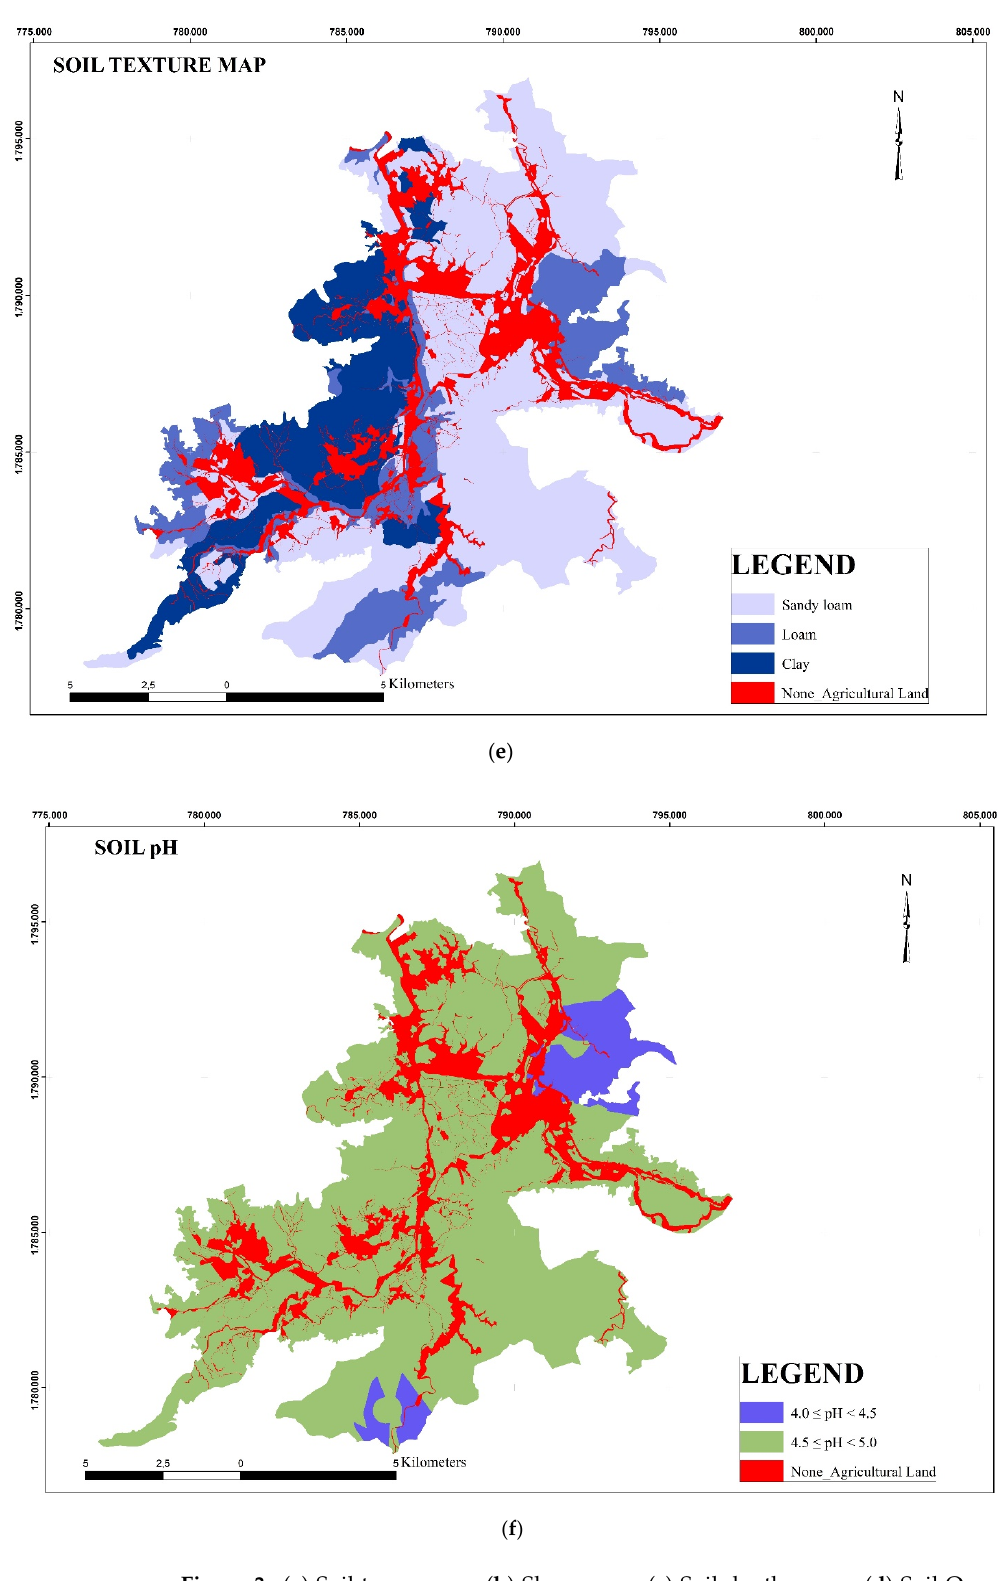
Figure 3. ( a ) Soil types map. ( b ) Slope map. ( c ) Soil depths map. ( d ) Soil Organic Carbon map. ( e ) Soil texture map. ( f ) Soil pH Table 5. Attributes of each criterion and its score.